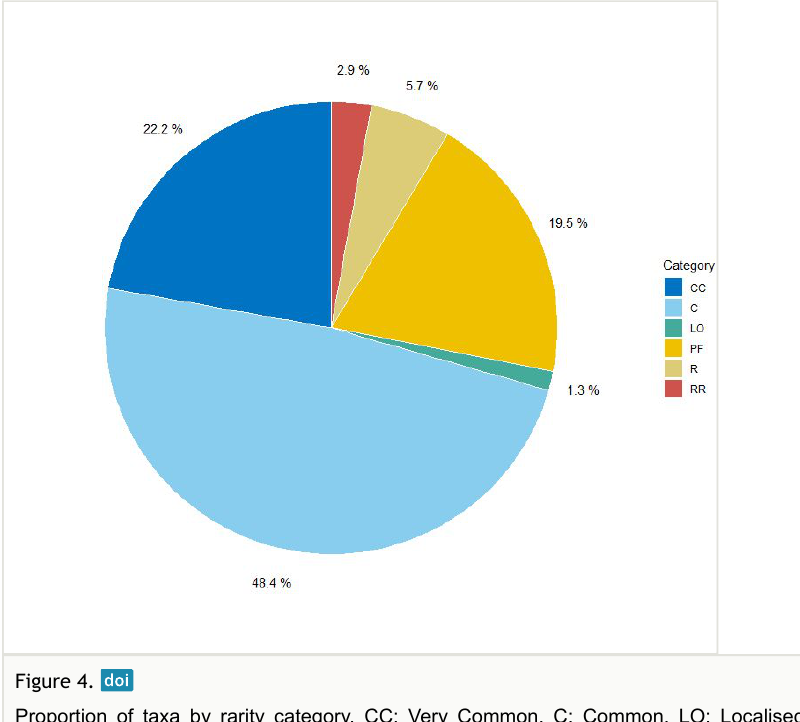
Proportion of taxa by rarity category. CC: Very Common, C: Common, LO: Localised, PF: Uncommon, R: Rare, RR: Very